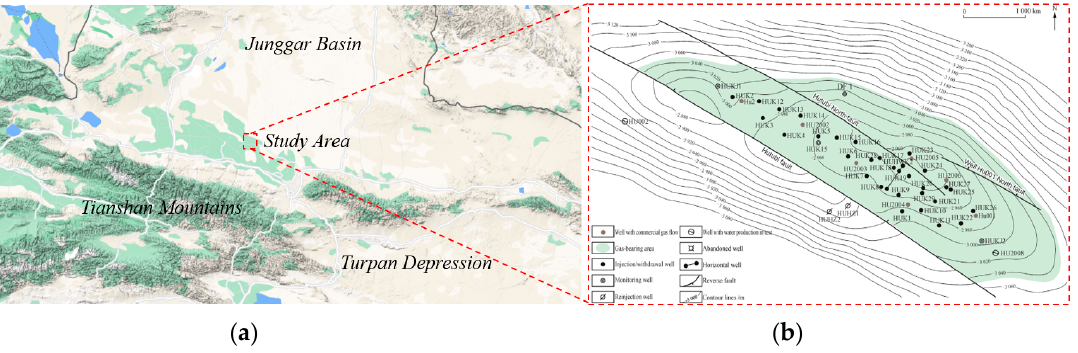
Figure 10. ( a ) Regional location of the study area. ( b ) Structure and well location map of the study area (modified from Zheng et al.